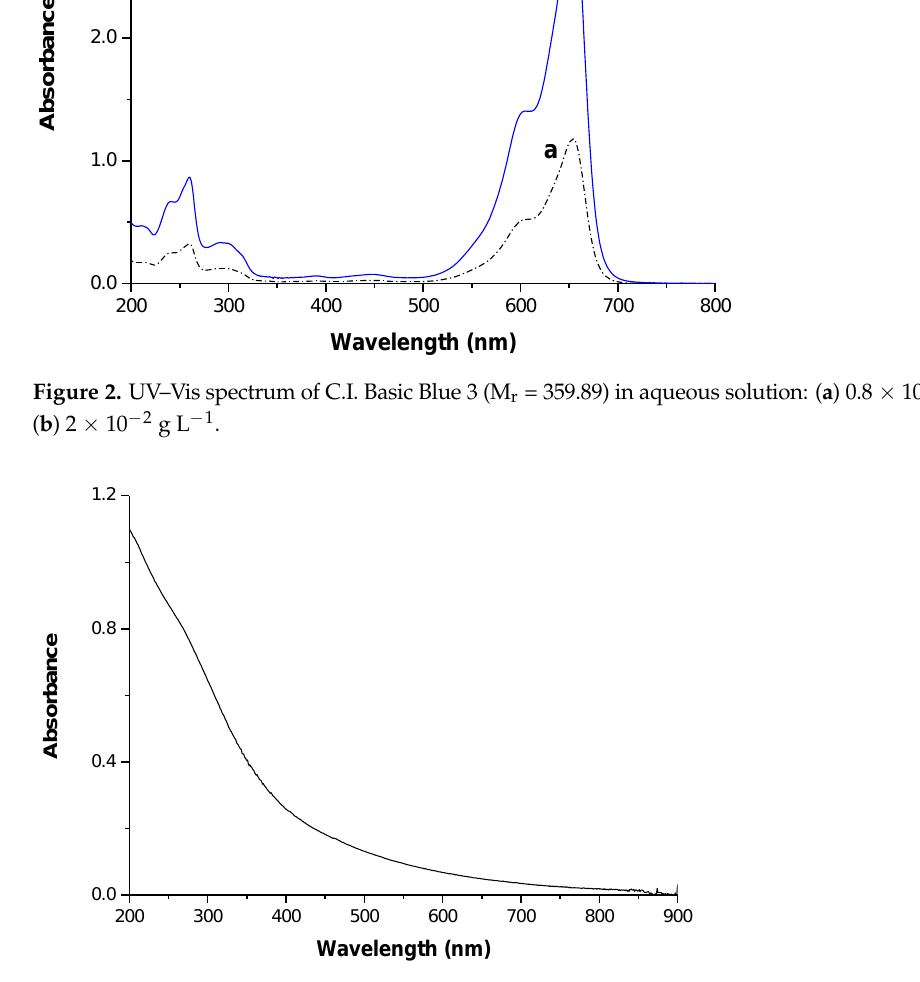
Figure 3. Plot of absorbance as a function of wavelength for potassium humate in water (2 × 10 − 2 g L − 1 ).